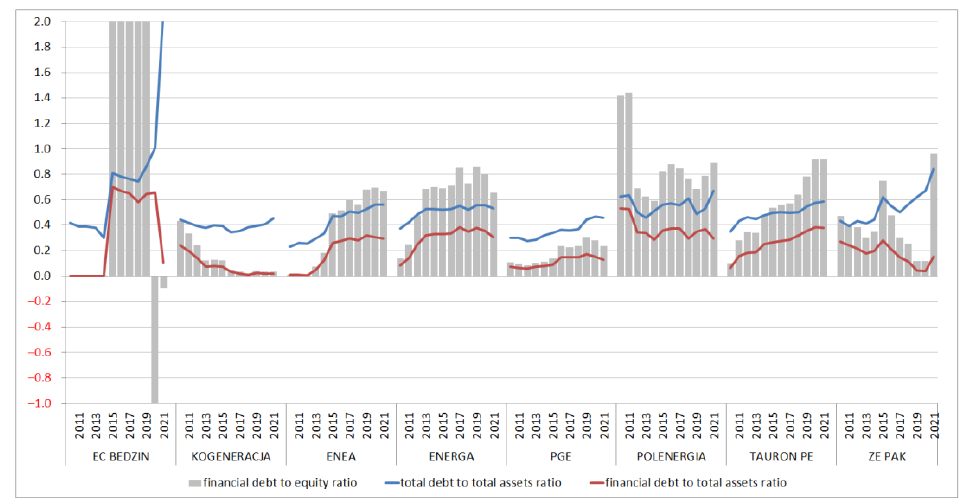
Figure 11. Debt level in analyzed energy companies. Source: own elaboration.